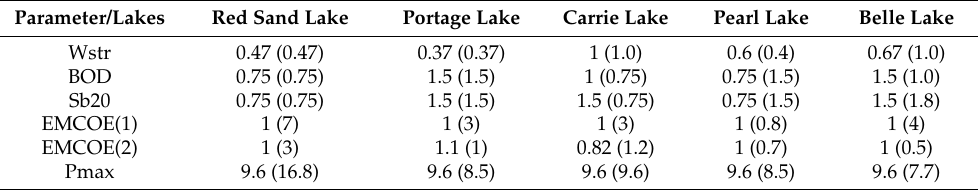
Table 3. Suggested and calibrated values of model calibration parameters for five study